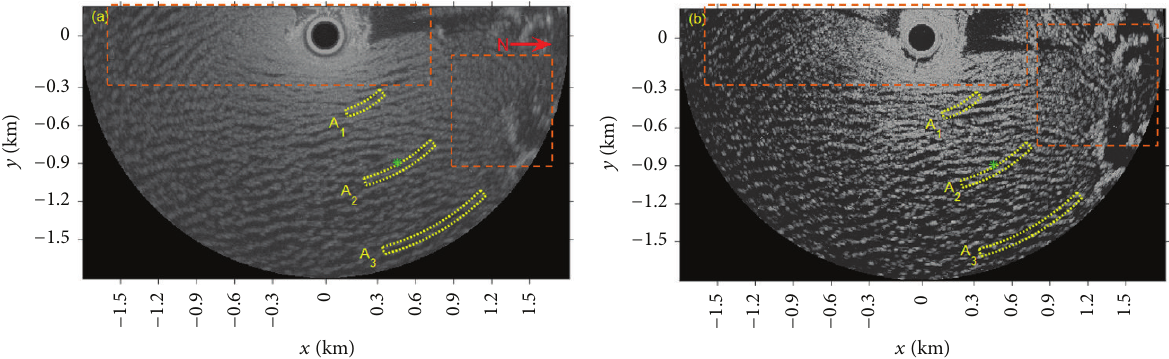
Figure 2: Two X-band marine radar images captured at 12:15 on December 27, 2014, by (a) VV polarized radar and (b) HH polarized radar. The red arrow points to the north direction. The yellow bins A1, A2, and A3 are the study regions. The green stars denote the location of the buoy. The brown boxes show the refraction of waves.